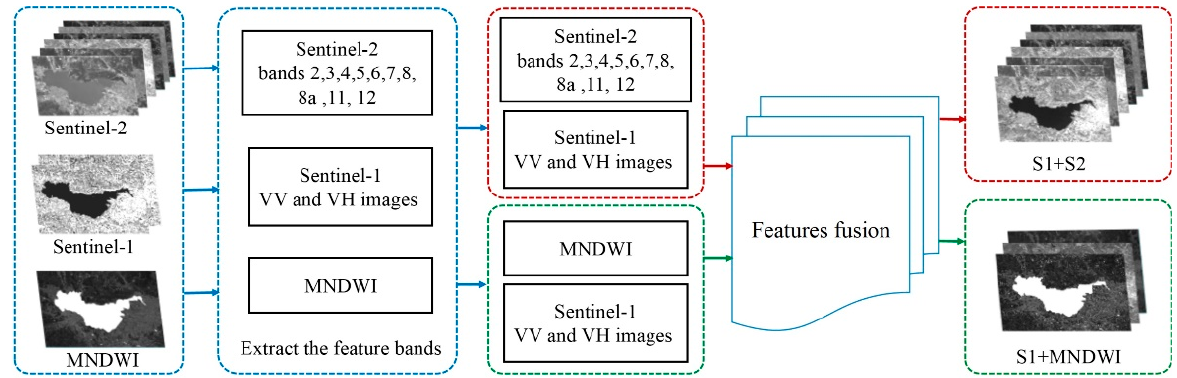
Figure 5. The conceptual fusion framework of Sentinel-1/2 spectral and polarization data.